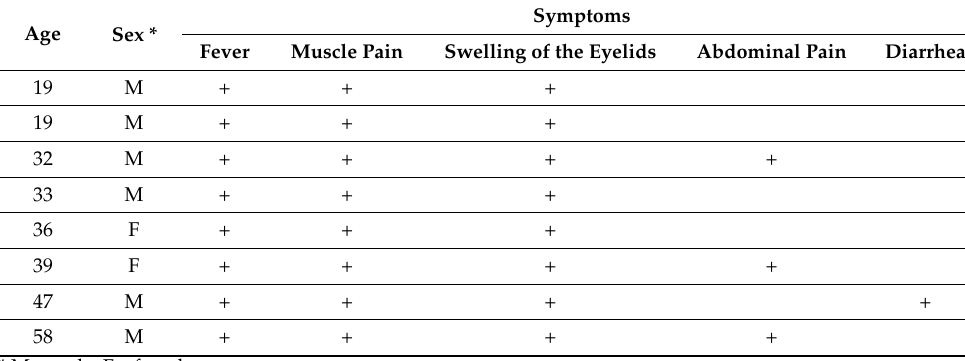
Table 1. The symptoms observed in cases of confirmed trichinellosis by age and gender (data obtained from Regional Sanitary Inspection in Poznan).